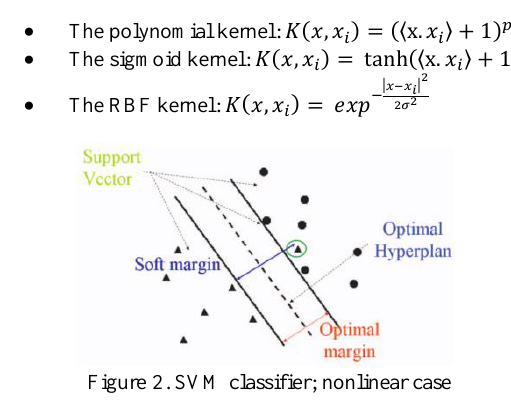
Figure 2. SVM classifier; nonlinear